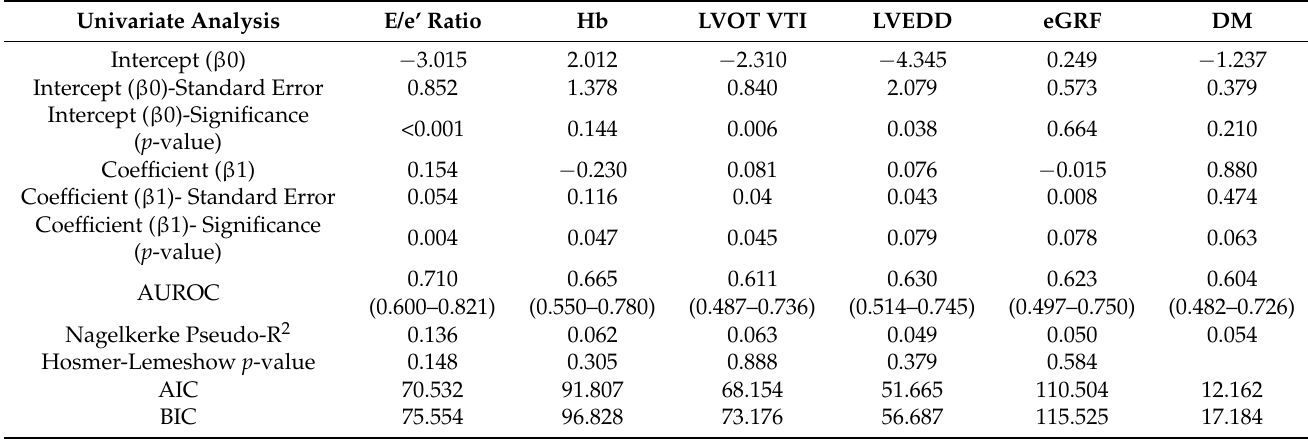
Table A1. Univariate analysis. Intracohort statistically significant variables were studied univariately. Univariate